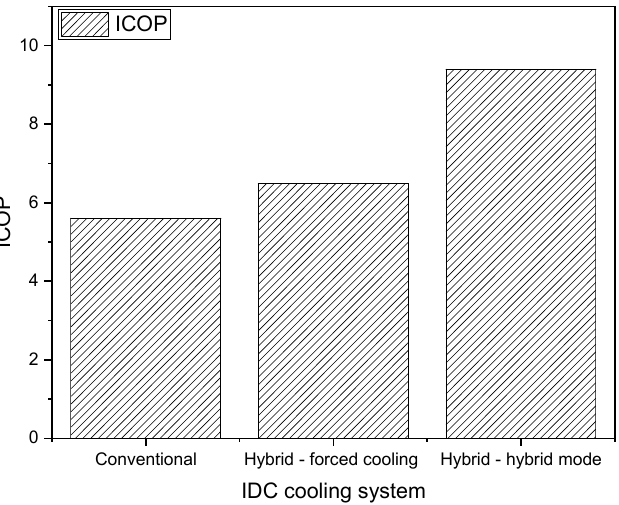
Figure 21. Integrated COP comparison for cooling systems. Table 6. Water temperature data for average weighting in the Republic of Korea.